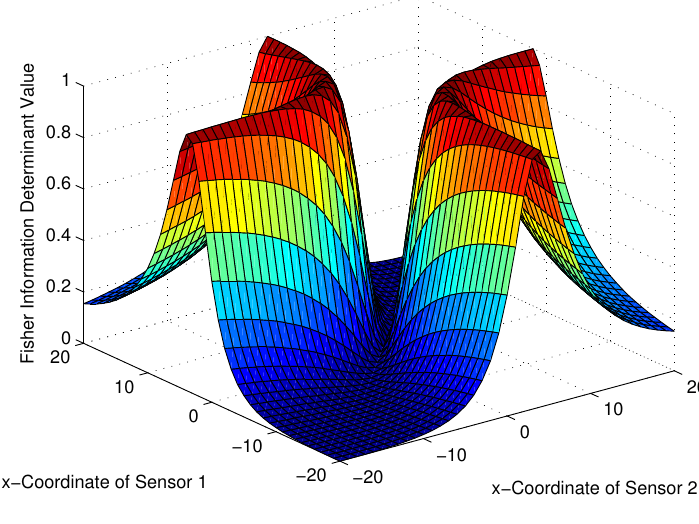
Figure 9. Variation of Fisher information determinant value with the range sensors positions.